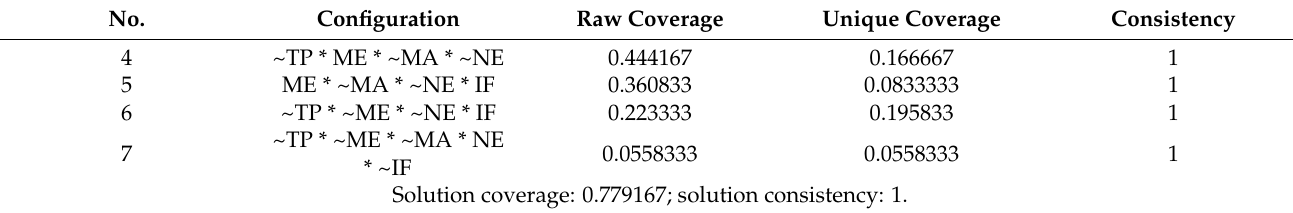
Table 5. Results of conditional combination path analysis on online public opinion of public emergencies not rebounding.